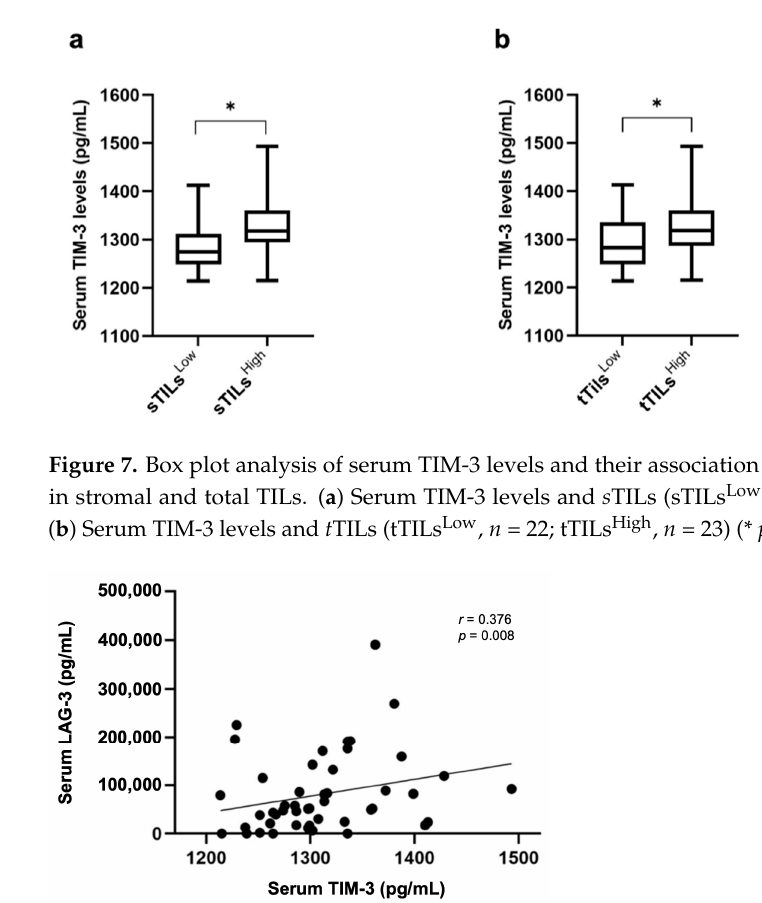
Figure 8. Spearman’s correlation of serum TIM-3 and serum LAG-3 levels ( r = 0.376; p = 0.008).